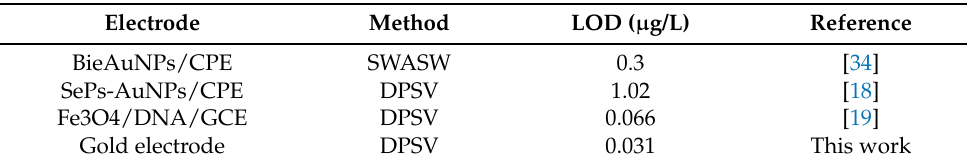
Table 2. Comparison of analytical performance for the determination of trace mercury in the aque- ous